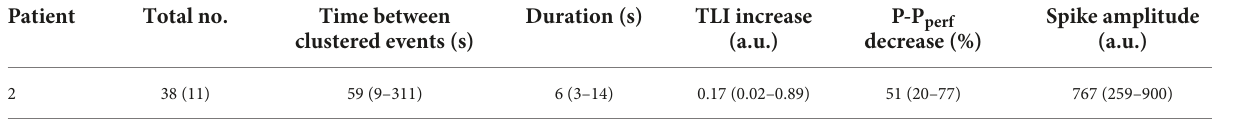
TABLE 2 Characteristics of the short-term variations observed in the measurement data from Patient 2.